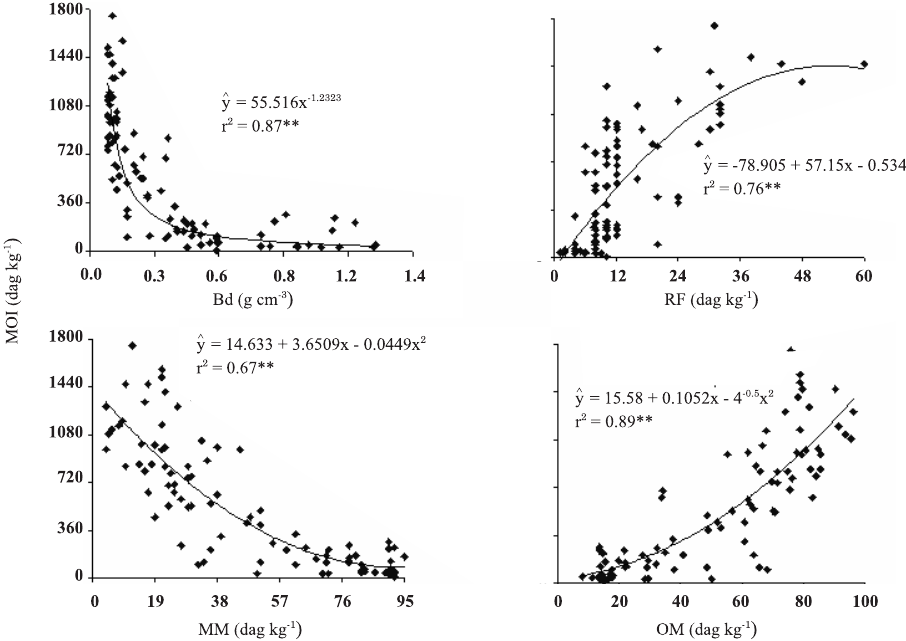
Figure 3. Moisture content (Moi) and its relations with: bulk density (Bd); rubbed fibers (RF); mineral material (MM); organic matter (OM) and the respective regression equations and correlation coefficients in the peatland conservation unit Pau-de-Fruta, Diamantina,